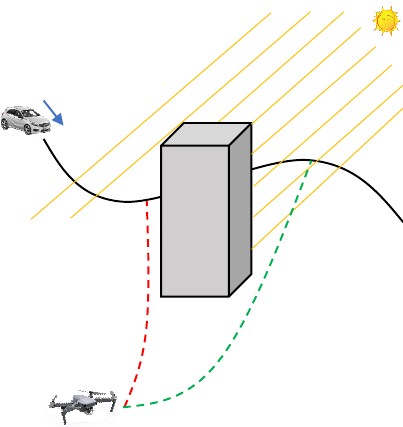
Figure 4. Illustration of the potential benefit offered by the margin energy capacity. The margin energy capacity allows the UAV to take a path with some part having no Line-of-Sight (LoS) with sun to reduce the revisit